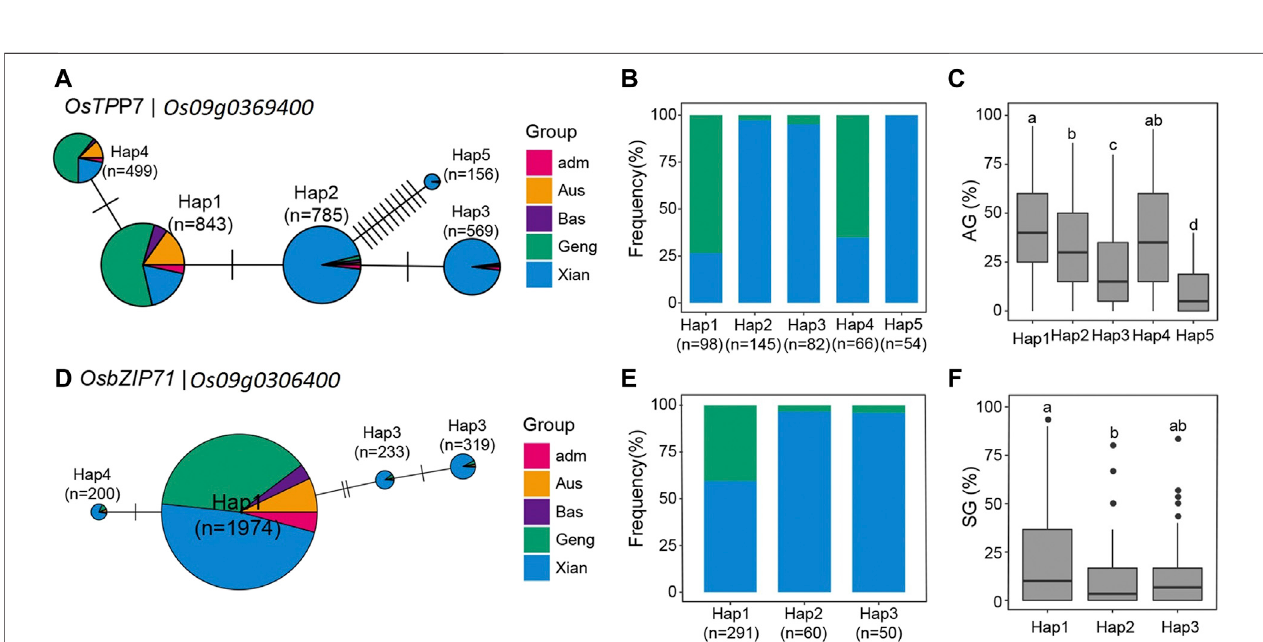
FIGURE 3 | (A) for OsTPP7 and (D) for OsbZIP71; Frequencies of (B) , 5 haplotypes(Hap) of OsTPP7 and (E) , 3 haplotypes(Hap) of OsbZIP71 in subgroups of 3RGP; The distribution of AG for the (C) , 5 Haps of OsTPP7 and the distribution of SG the (F) , 3 Haps of OsbZIP71. Different letters above each boxplot indicate signi fi cant differences among haplotypes according to Tukey ’ s honest ’ s signi fi cant difference test ( p <